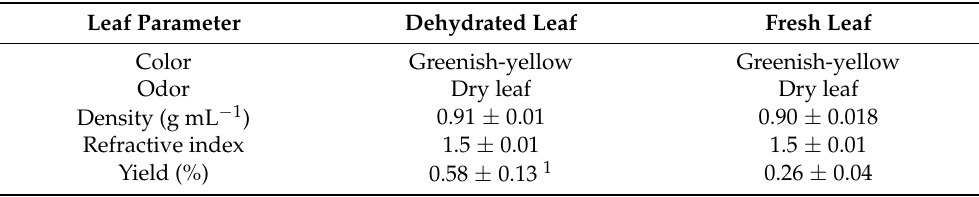
Table 1. Characteristics of the essential oil extracted from the Cedrela odorata dehydrated leaves. Data are the average of n = 3 and are expressed as mean ± standard deviation. The leaf batch was collected in June 2018. Leaf Parameter Dehydrated